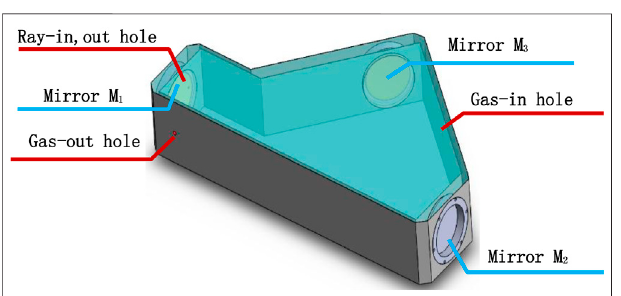
FIGURE 3 | Mechanical structure drawing of the V-shape MPC includes sphericalmirrors M 1 , M 2, and M 3 ;gas-in and gas-out hole, and ray-in andray- out